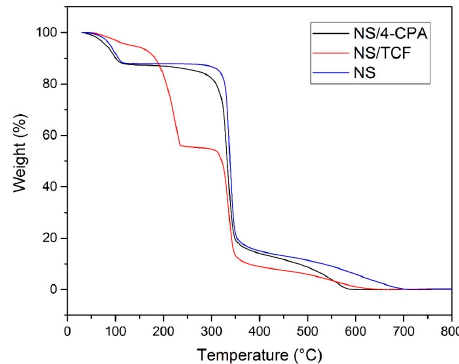
Figure 3. Thermogravimetric analysis (TGA) analysis for nanosponges (NS), the NS– 2,3,4,6-tetrachlorophenol (TCF) complex and the NS–4-chlorophenoxyacetic acid (4-CPA) complex.